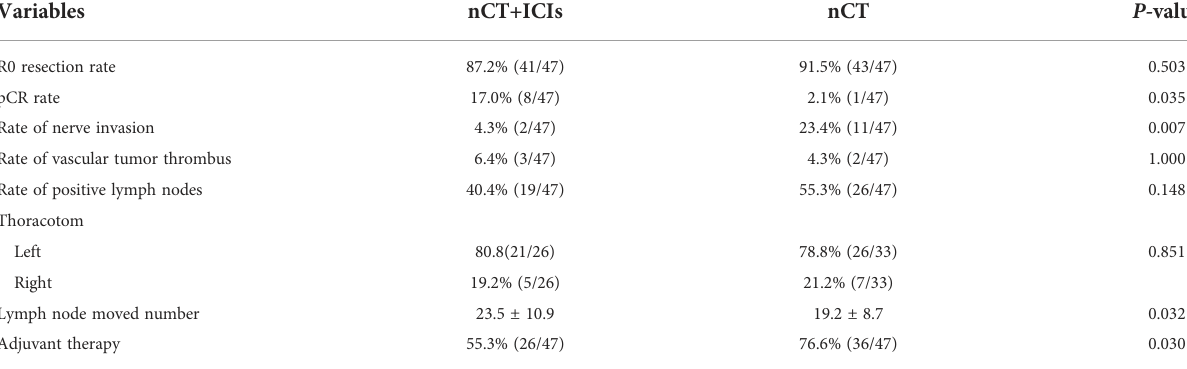
TABLE 3 Surgical treatment